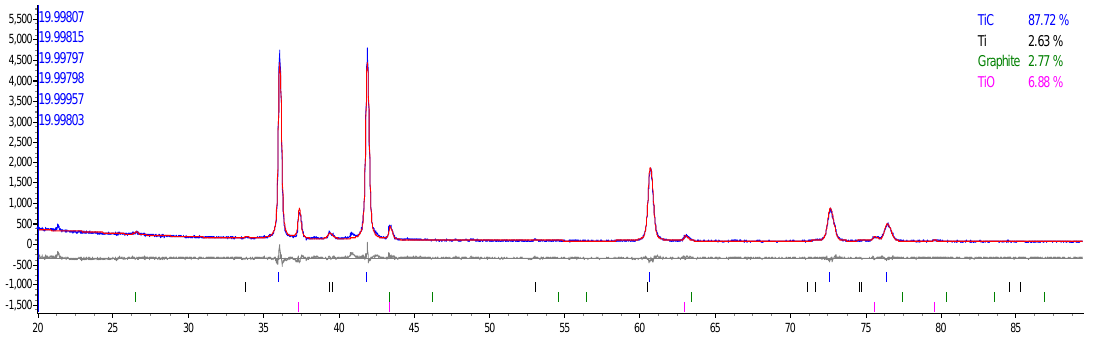
Figure 2. X-ray di ff raction patterns of initial mixture and the sample obtained at 1000 ◦ C. Results of Figure 2. X-ray diffraction patterns of initial mixture and the sample obtained at 1000 oC. Results of calculation of unit cell parameters are presented in Table calculation of unit cell parameters are presented in Table 1. Table 1. Concentrations of the components and parameters of TiC estimated from full-profile Rietveld analysis of X-ray diffraction data for TiC-900 and TiC-1000 samples. Phase Composition Sample (wt.%)